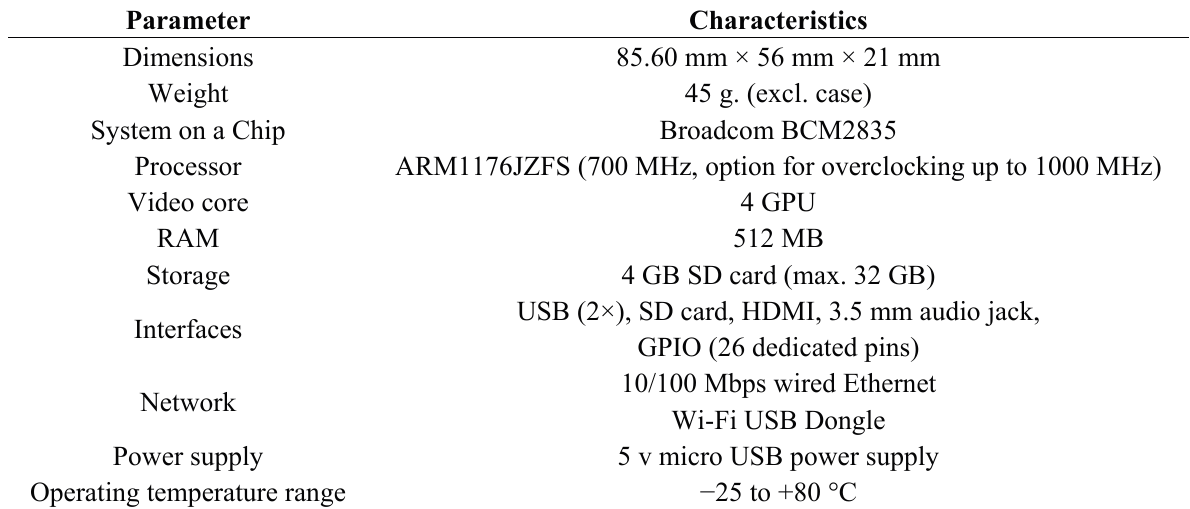
Table 2. Characteristics of RaspberryPI, model